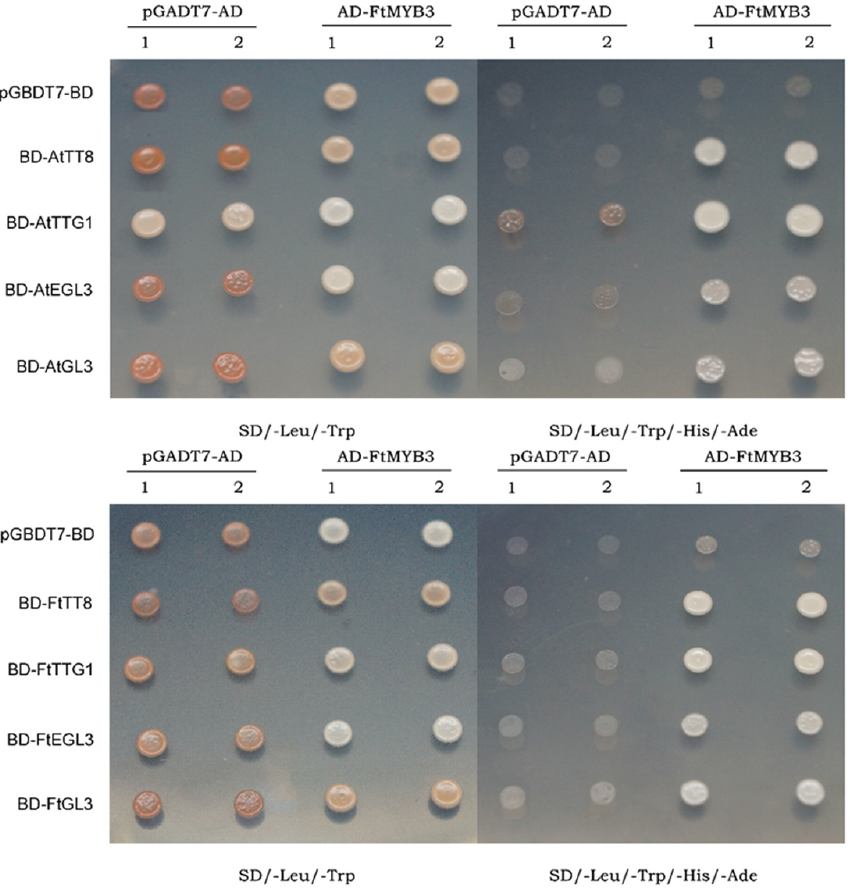
Figure 6. Interaction proteins of FtMYB3. FtMYB3 was fused to the pGADT7 vector, and FtTT8, FtTTG1, FtEGL3, or FtGL3 was fused to the pGBKT7 vector. SD/-Trp-Leu medium was used to screen the transformation for plasmids, and SD/-Leu-Leu-His-Ade medium was used to screen the transcriptional activation of HIS3 gene. Colony growth was monitored after 7 days. Yeast cells trans- formed with the empty plasmids pGADT7 and pGBKT7 were used as controls, respectively. Two independent technical replicates of each strain were analyzed.